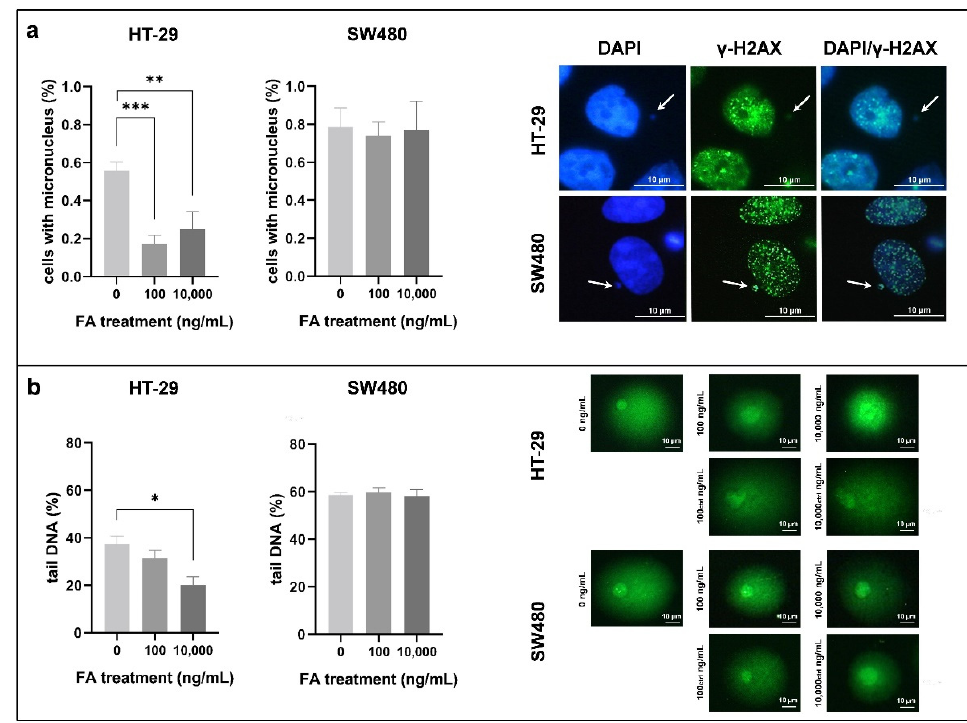
Figure 2. Genomic stability detection of HT-29 and SW480 cells exposed to different folic acid (FA) concentrations (0, 100, 10,000 ng/mL). ( a ) Micronucleus (MN) scoring was performed on DAPI- and anti- γ -H2AX-stained slides. Left: We obtained the results by proportioning the cells with MN with all cells counted (** p ≤ 0.01, *** p ≤ 0.001). Right: Representative γ -H2AX-positive micronuclei are indicated with arrows. ( b ) DNA integrity was evaluated with comet assay, additionally. Left: Graphs show the changes in genomic stability in consideration of comet tail DNA percentage (* p ≤ 0.05). Right: Characteristic comets of both cell lines were captured following different treatments. FA: folic